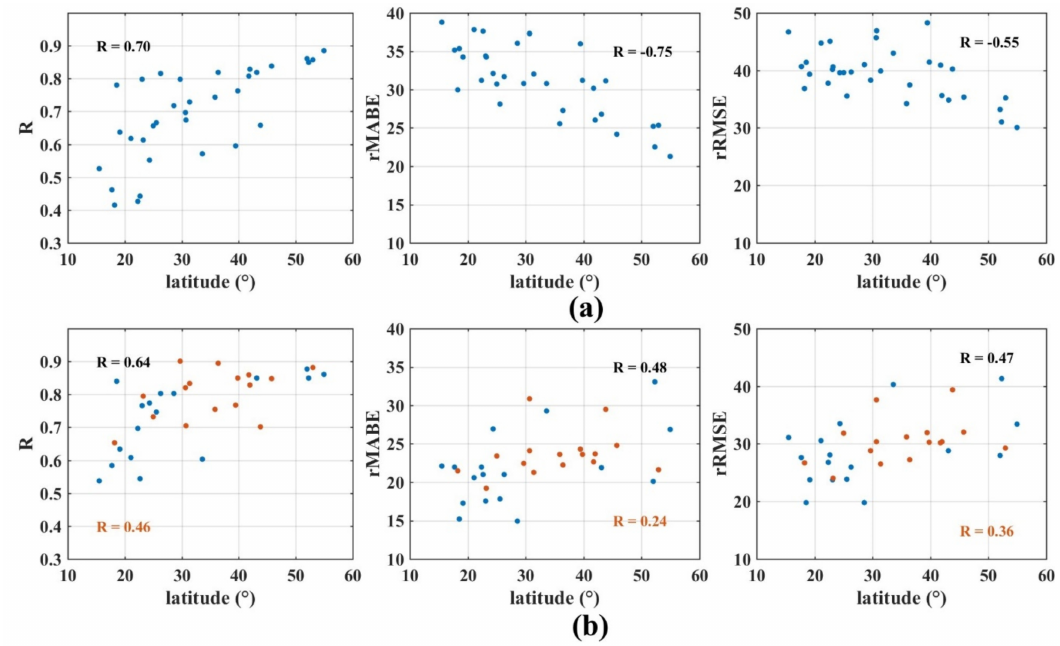
Figure 6. Latitudinal dependency of data accuracy: ( a ) results for ERA5; ( b ) results for estimates of JiEA. Spatial distribution corresponds to Figure 5. The correlation coe ffi cients (R) indicate a linear relationship. For (b), brown dots represent the selected CMA